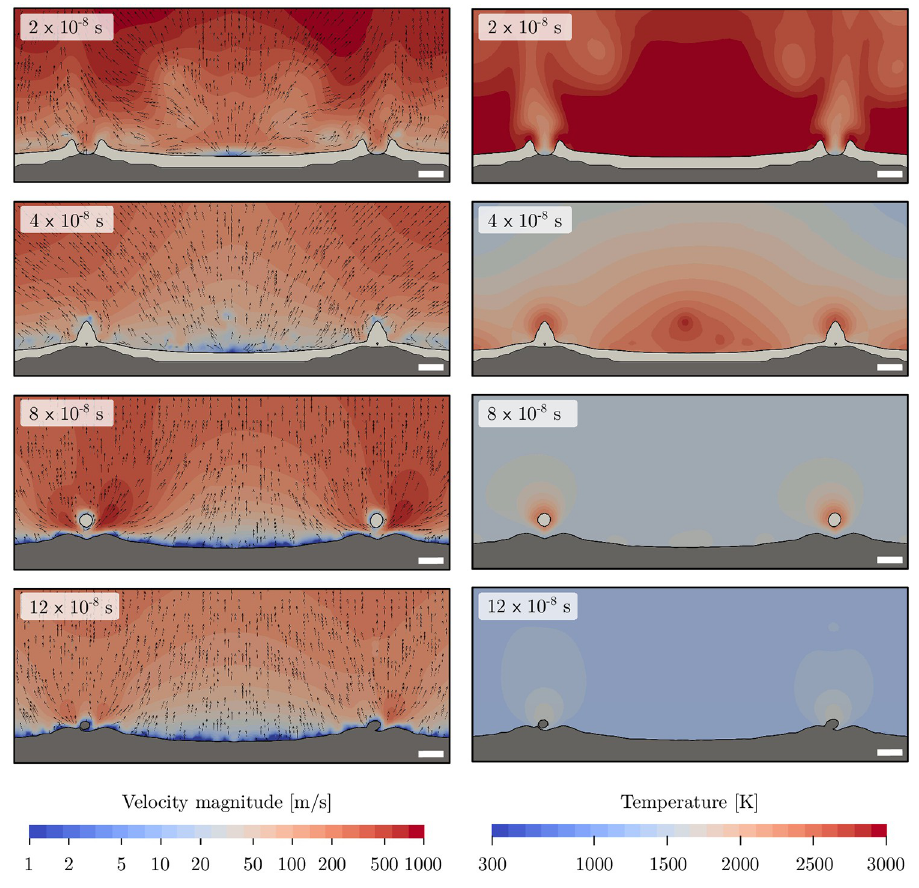
Fig 9. Velocity magnitude and vectors (left) and temperature of the gas phase (right) for a parallel polarization orientation at 4.2 J/cm 2 . The solid stainless steel phase is indicated in dark grey while the melt phase is in light grey. Note: Velocity is shown in a logarithmic scale, and the white bar corresponds to 1 µ